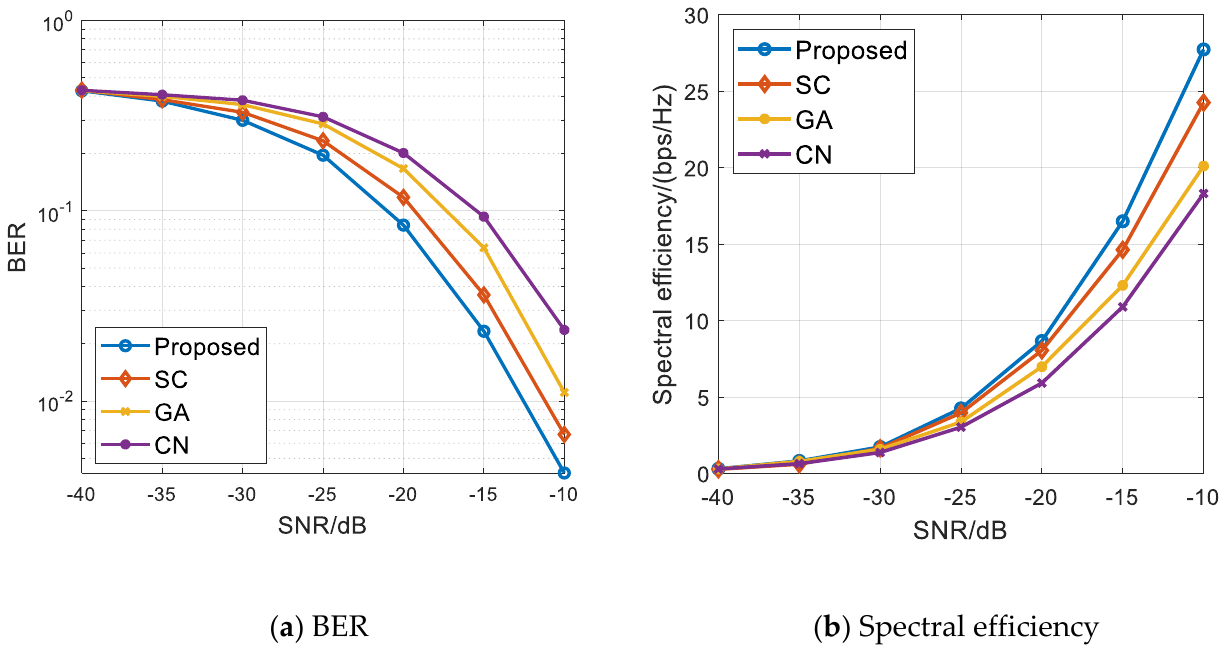
Figure 4. Multi-user scheduling simulation results when M = 4 and N t = 256. ( a ) BER of all the algorithms; ( b ) Spectral efficiency performance of all the algorithms.